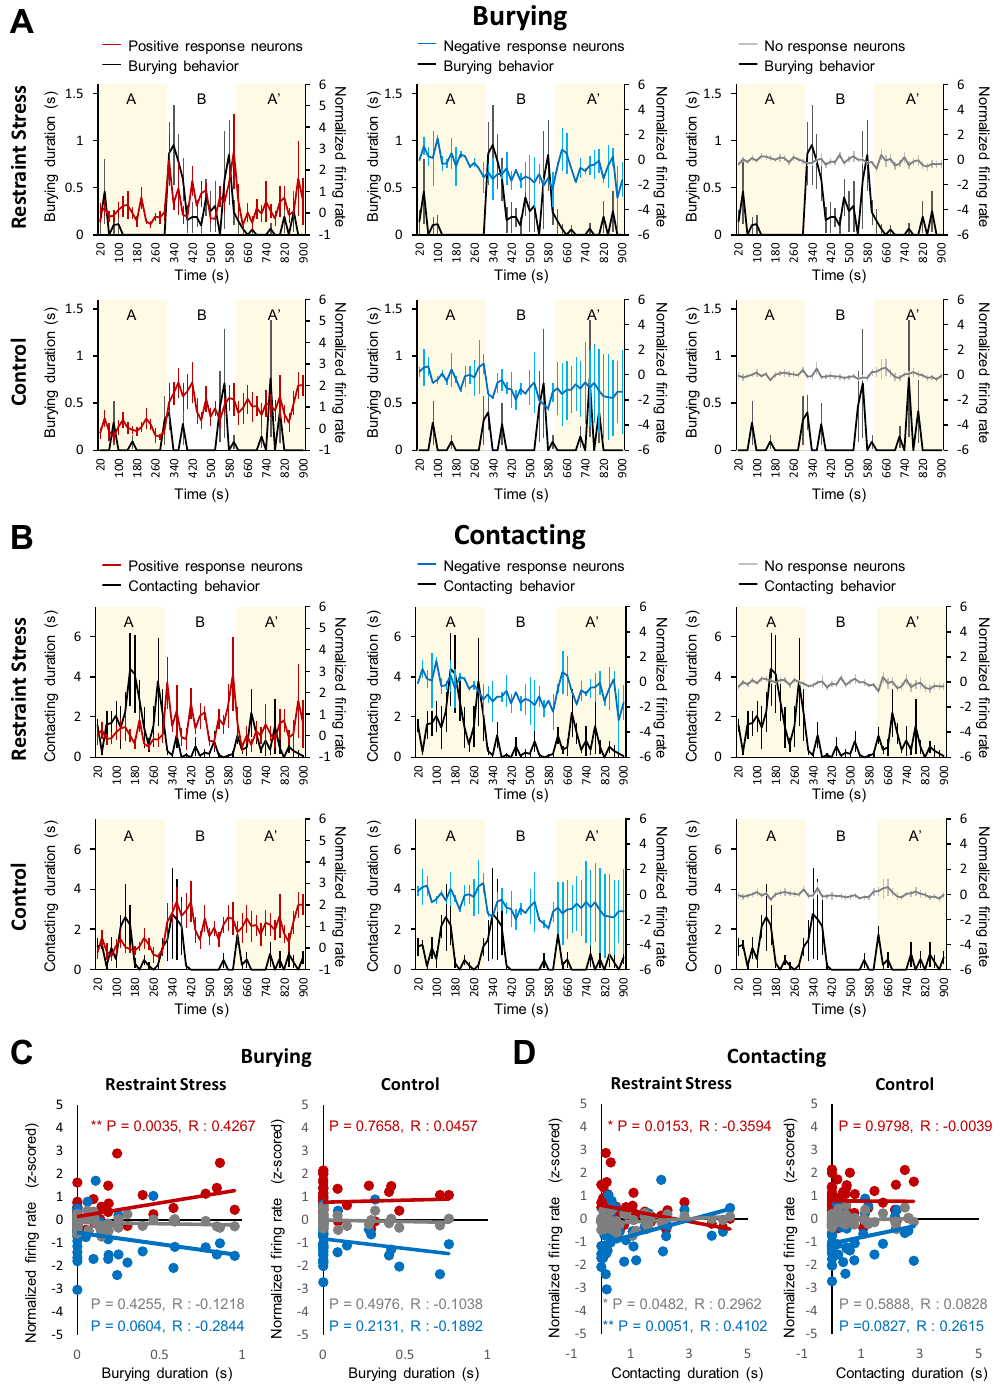
Figure 5. Relationship between fear and anxiety-like behaviors and aIC neuronal activities. ( A ) Normalized average firing rate plotted with the duration of burying behaviors in the restraint stress (top) and control (Bottom) groups. ( B ) Normalized average firing rate plotted with the contacting behavior of a restrainer- resembling object in the restraint stress (top) and control (Bottom) groups. ( C ) Pearson’s correlation between normalized firing rate and the duration of burying behaviors in the restraint stress (left) and control (right) groups. ( D ) Pearson’s correlation between normalized firing rate and the contacting behavior of a restrainer- resembling object in the restraint stress (left) and control (right) groups. ( A–D ) red line: positive response neurons, blue line: negative response neurons, gray line: no response neurons, black line: behaviors (either burying or